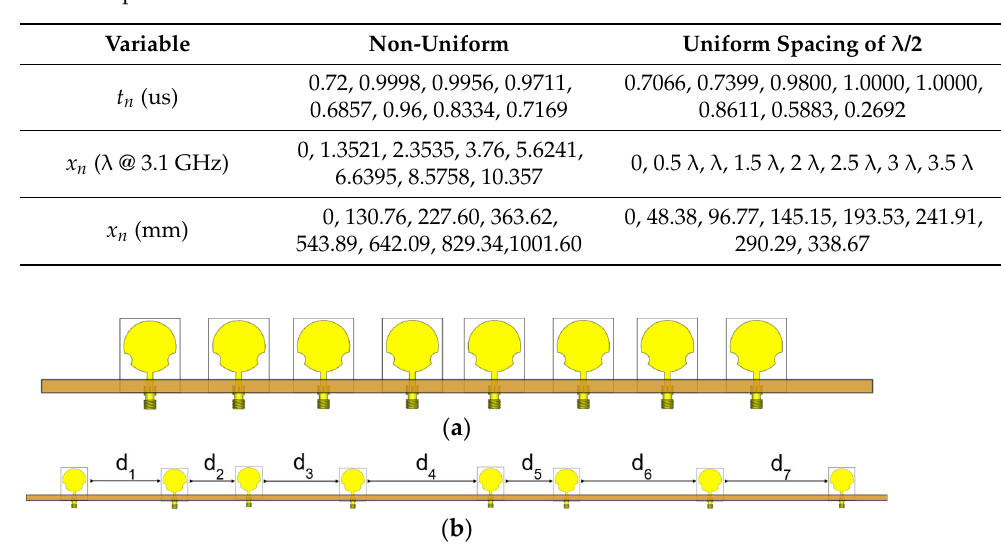
Figure 2. TMA: ( a ) non ‐ uniform; ( b ) uniform spacing of λ /2.